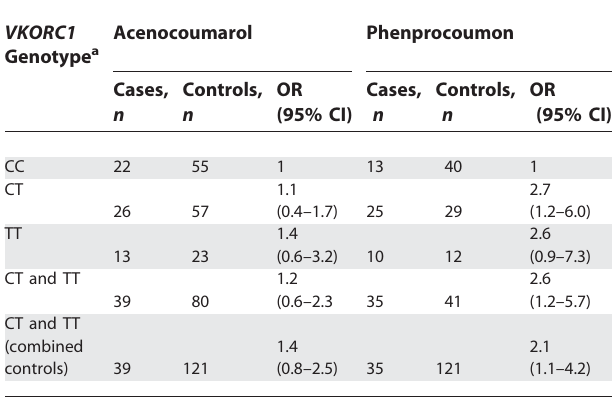
Table 2. Numbers of Cases and Controls for the Different VKORC1 Genotypes and Crude ORs for Bleeding under VKA